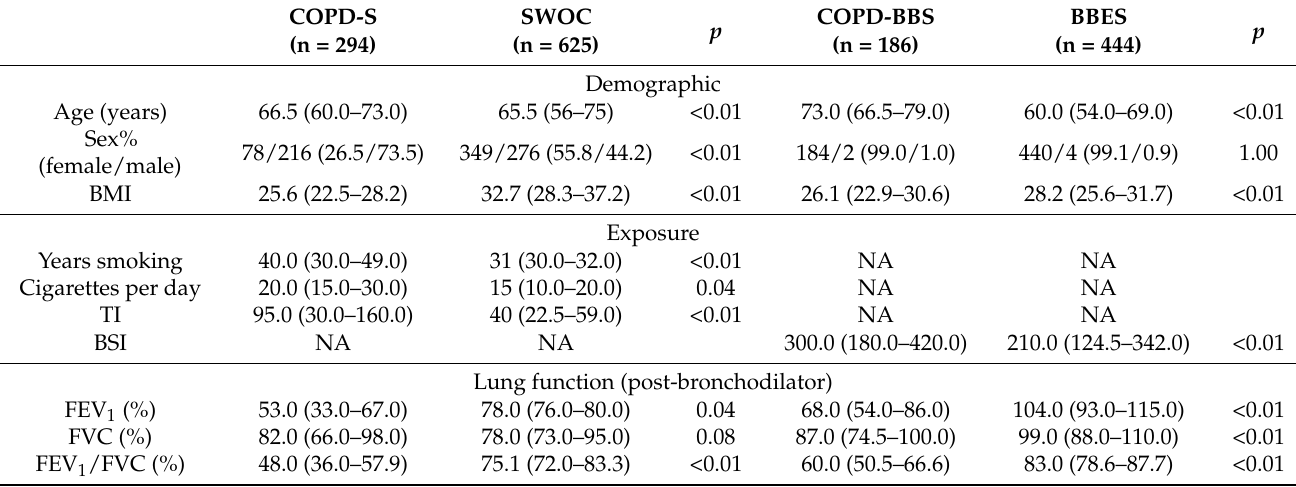
Table 1. Demographic and clinical data.